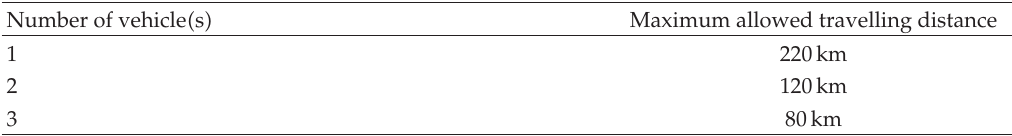
Table 8: The limit on travelling distances for